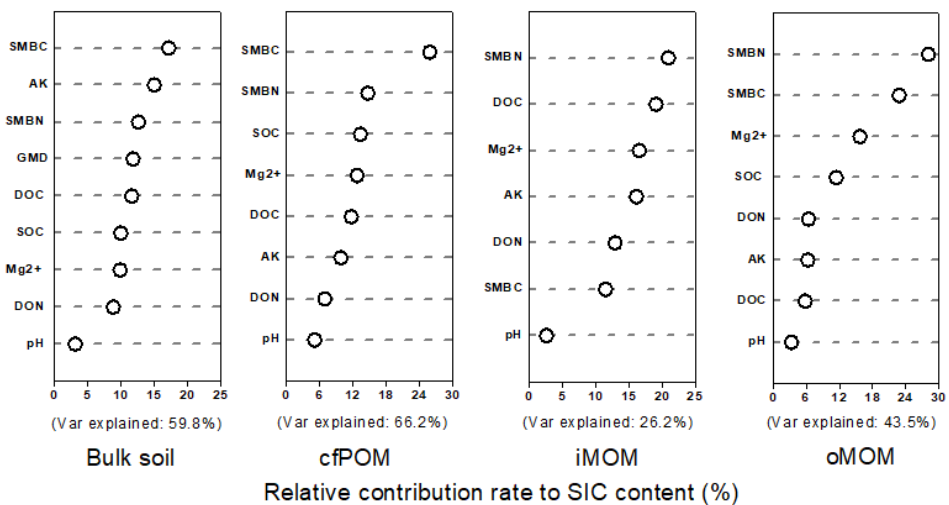
Figure A3. RF analysis of relative contribution rate to SIC content. cfPOM means coarse free partic- ulate organic matter fraction, iPOM means particulate organic matter inner microaggregate, iMOM means mineral-associated organic matter inner microaggregate, and oMOM means mineral-associ- ated organic matter outer fraction. MOM means mineral-associated organic matter fraction.